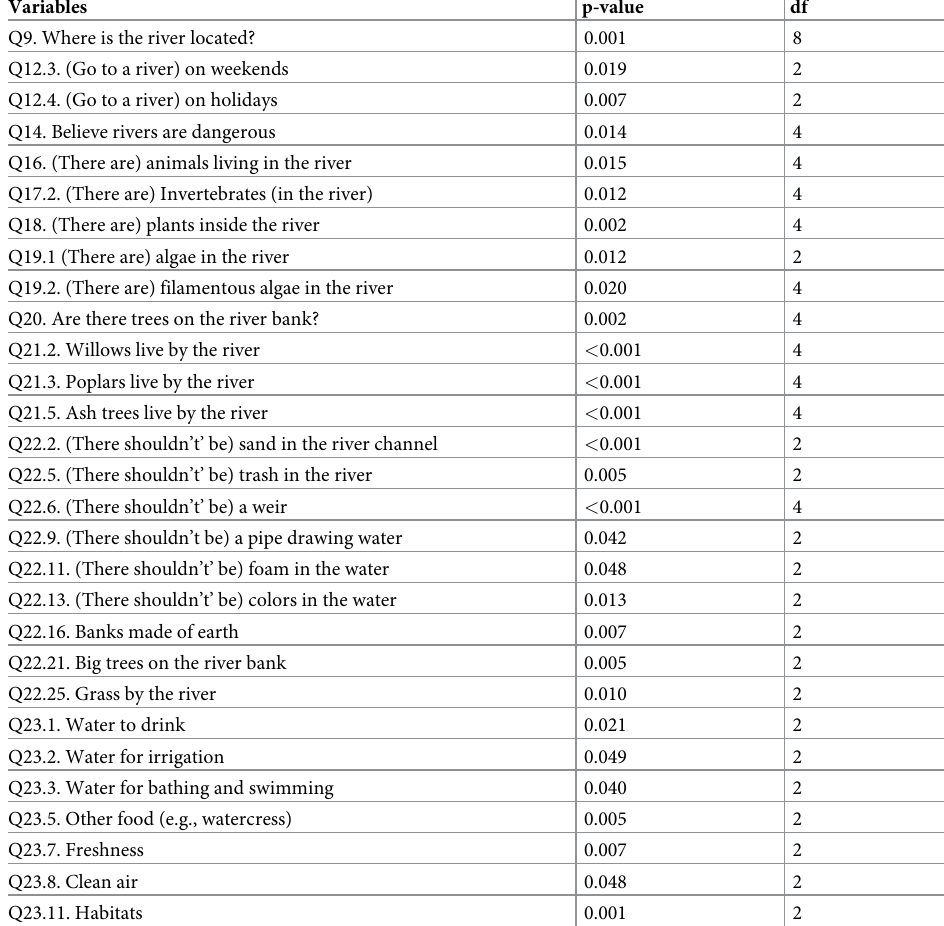
Table 1. Results of significant p-values (p < 0.05) for the Chi-square test between the Moments (M) and the cate- gorical variables. Variables p-value df Q9. Where is the river located? 0.001 8 Q12.3. (Go to a river) on